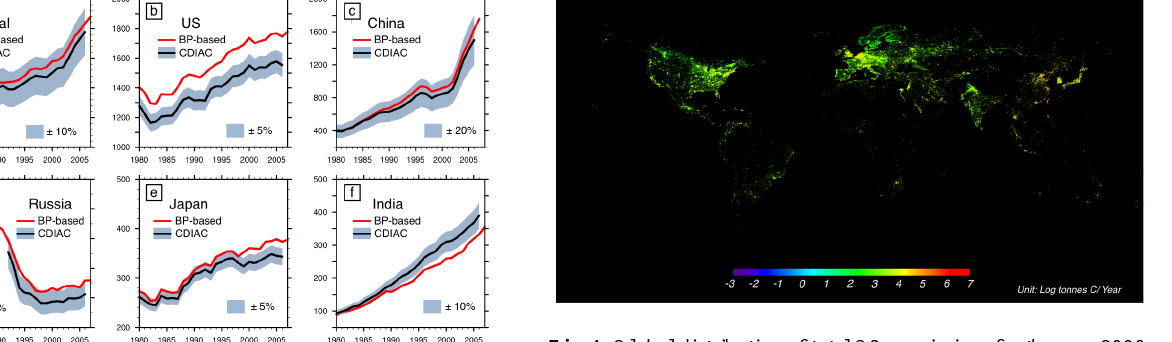
Fig. 4. Global distribution of total CO 2 emissions for the year 2006. The map was drawn using a reduced 5-km-resolution ODIAC inventory; therefore, the actual size of each pixel is 5 × 5 km 2 . Values are given in units of the log (base 10) of tonnes carbon 5 km − 2 year − 1 . 36